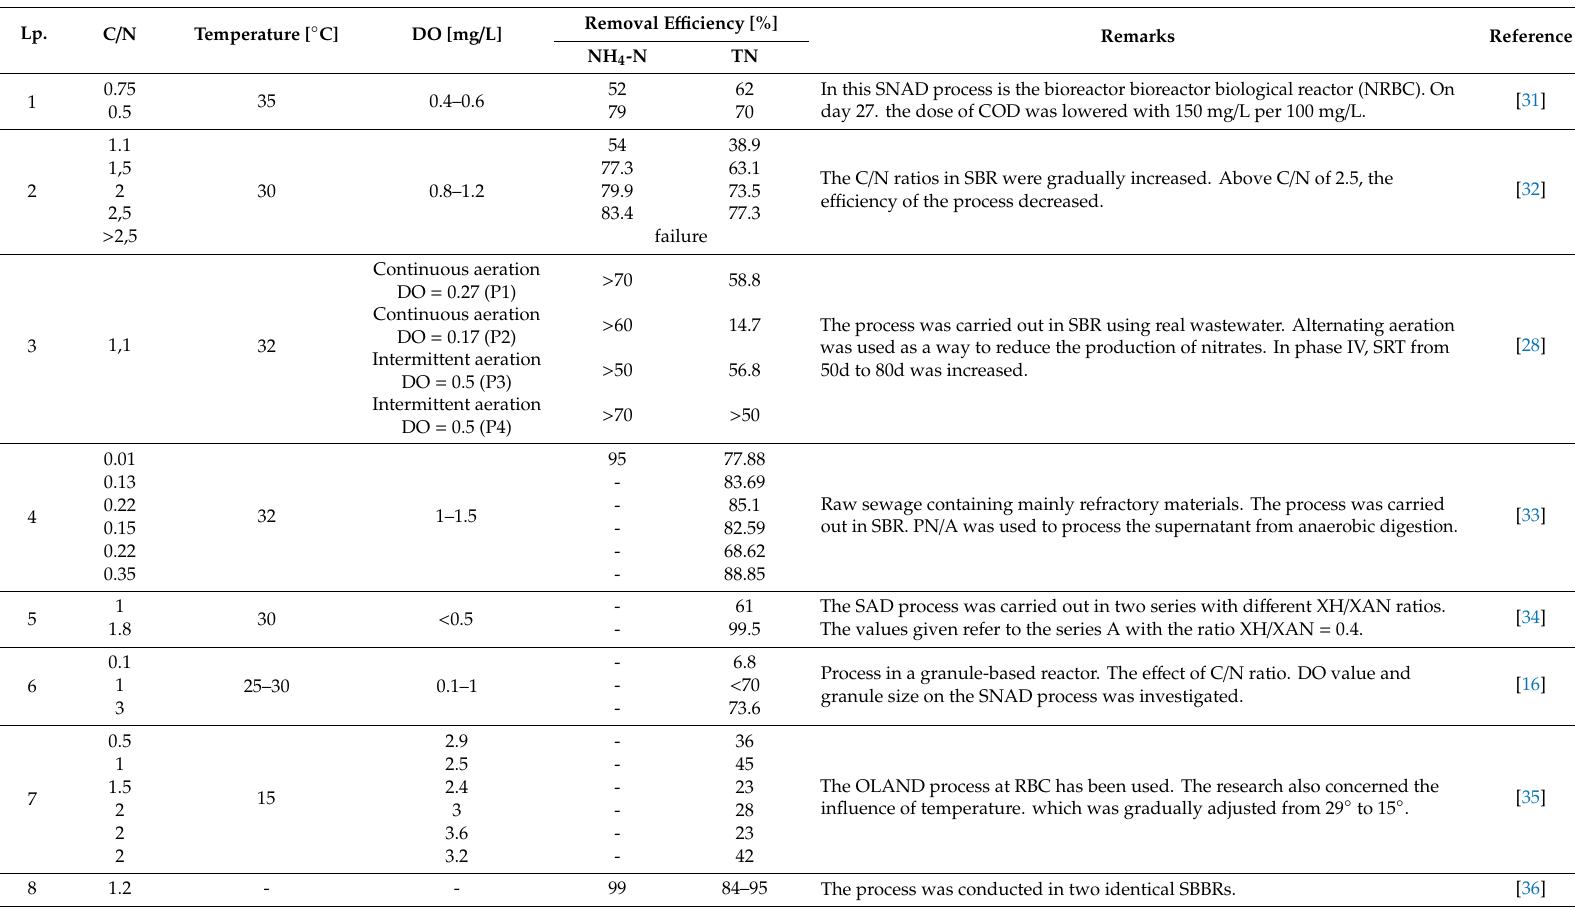
Table 4. The comparison of the obtained TN removal e ffi ciency and NH4-N removal e ffi ciency at di ff erent C / N ratios in other studies.